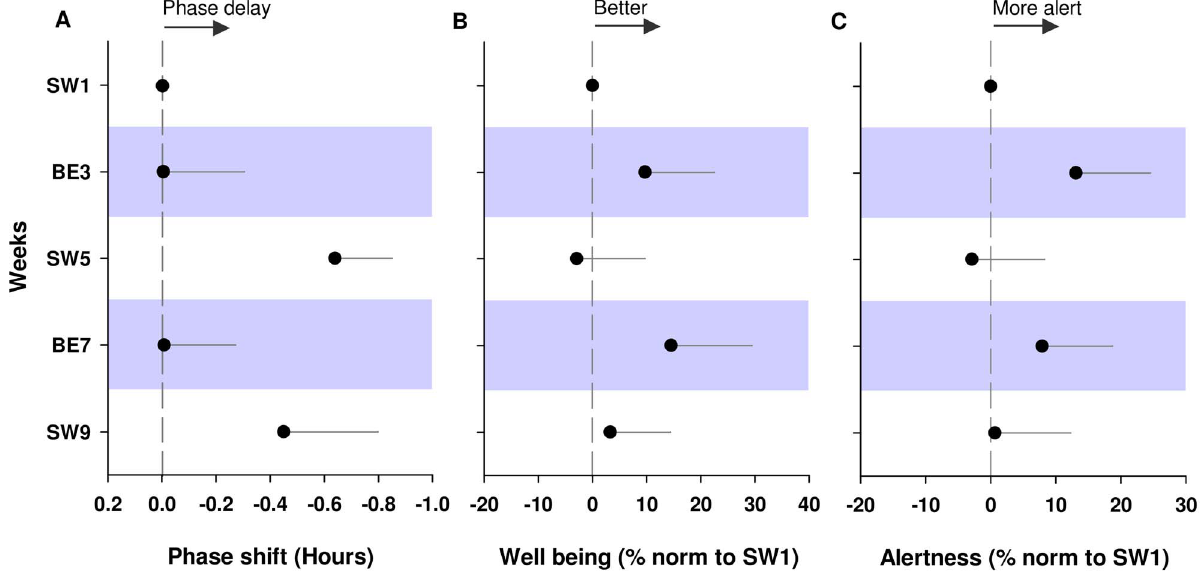
Figure 4. Circadian and neurobehavioral changes under SW and BE light condition over 9 weeks. Results were normalized to baseline SW1. A . Circadian phase was assessed using salivary DLMO. A delay in circadian phase of 2 0.64 6 0.21 h and 2 0.45 6 0.34 h was observed during weeks W5 and W9 respectively under SW light (p , 0.05). The circadian phase delay observed on week W5 appears to be corrected during BE light on week BE7, and is observed again on week SW9 under SW light. B . Well being was increased by BE light ( + 9.7 6 12.8% and + 14.5 6 14.9% on BE3 and BE7 respectively) compared to SW light ( 2 2.9 6 12.8% and + 3.2 6 11.2% during SW5 and SW9 respectively) (p , 0.05). C . Subjective alertness was marginally increased on weeks BE3 and BE7 under BE light (p=0.08) compared to SW light weeks SW5 and